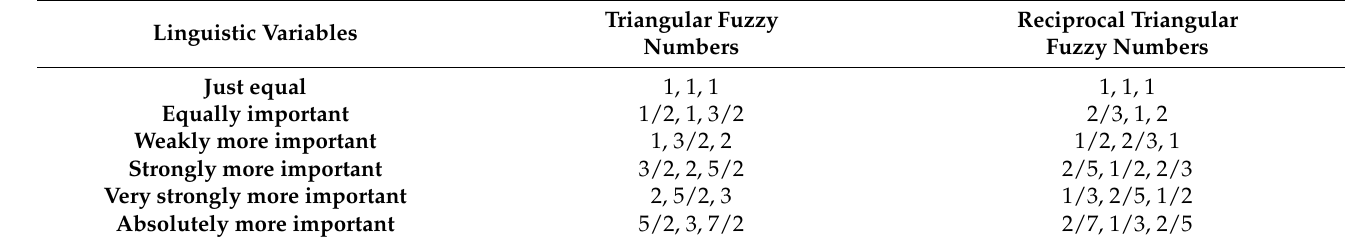
Table 3. Linguistic variables.